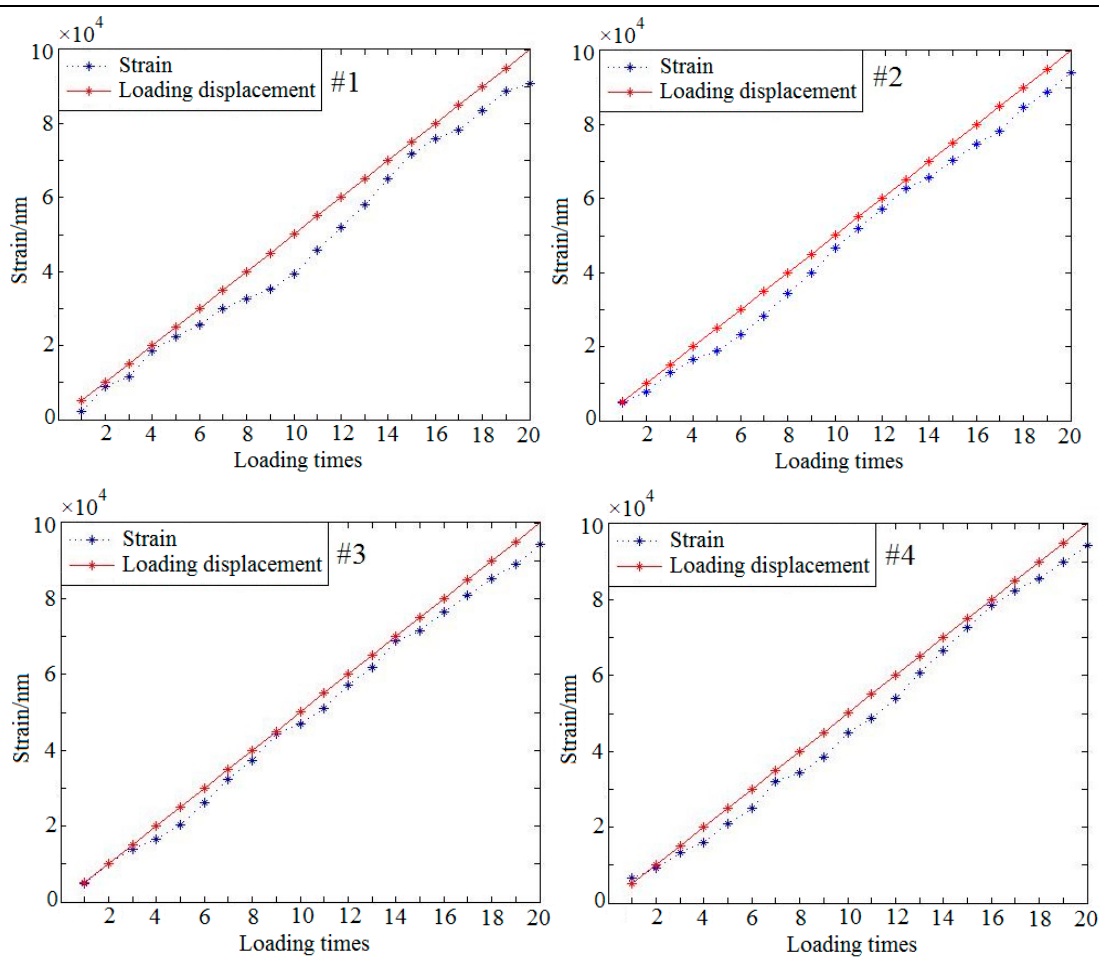
Table 2. The repeated test data of samples (#1~#4).